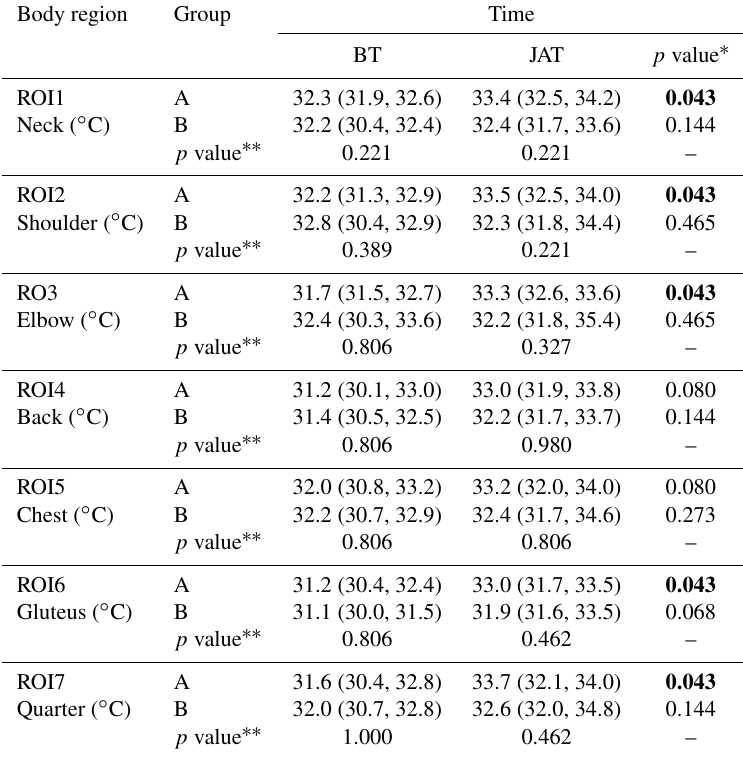
Table 1. Median (min, max) of the temperature measurements in the selected regions of the body surface (ROIs) before the training on the treadmill (BT) and just after the training (JAT) in two groups of horses and the results of the non-parametric significance